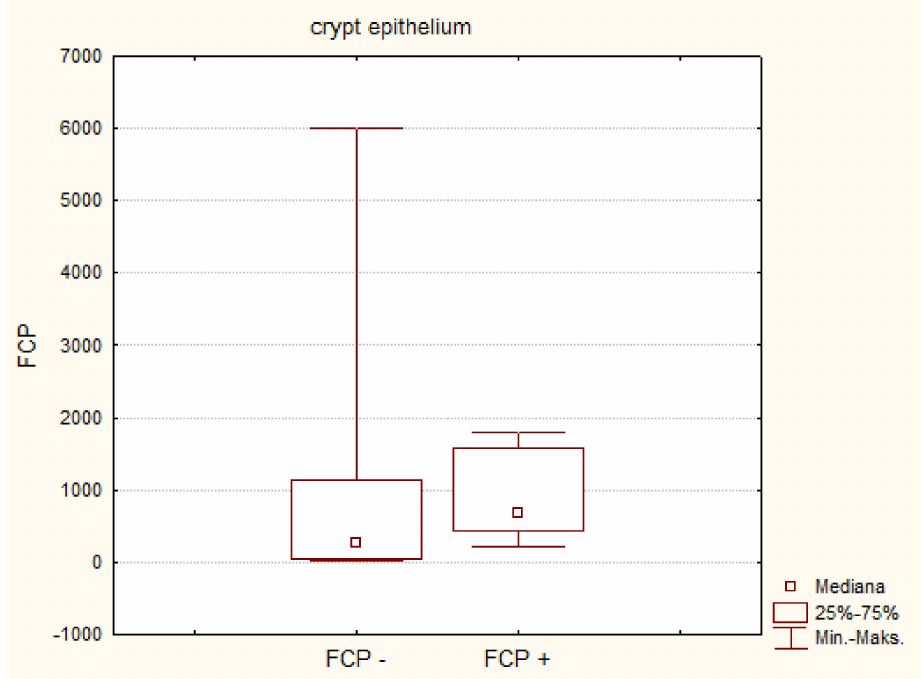
Figure 3. PCDAI and TCP in crypts in 57 patients included in the study; the higher the PCDAI, the higher the TCP in crypts ( p = 0.025).